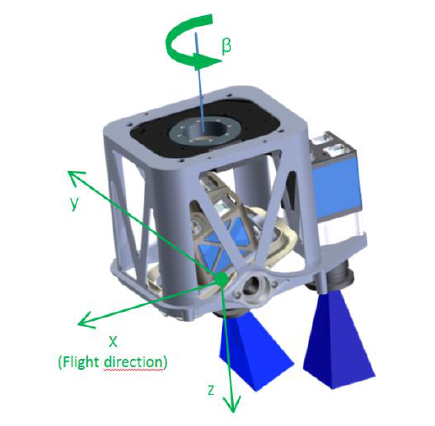
Figure 2. CAD-construction model